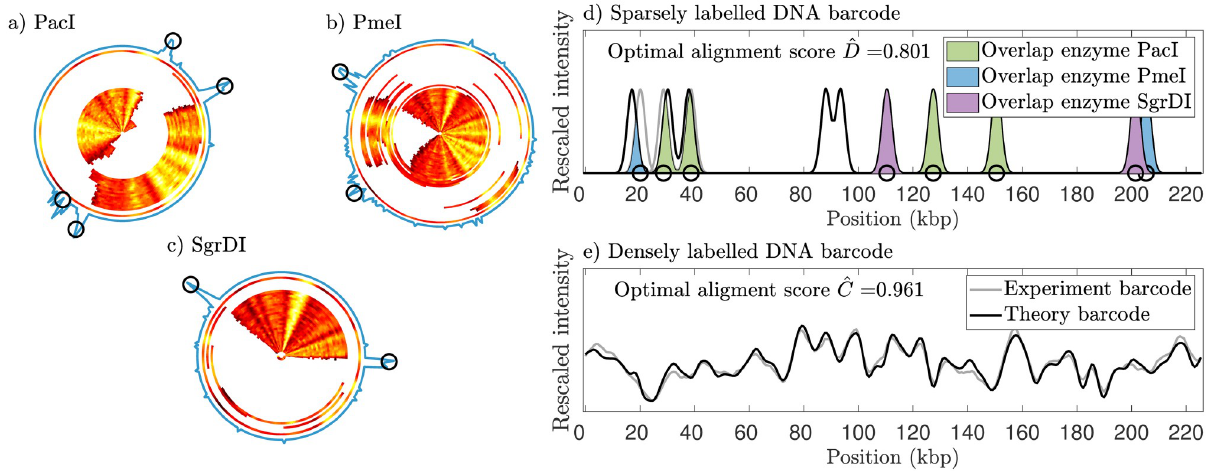
Fig 5. Experimental dually labeled barcodes for the 220 kbps plasmid. Three data sets containing fragments of a 220 kbps plasmid were obtained using competitive binding barcoding and sparsely cut-labeled barcodes obtained through full digestion using the restriction enzymes (a) PacI, (b) PmeI, and (c) SgrDI. The experimental competitive binding barcodes were aligned into a consensus barcode. The locations of cuts for each barcode are shown as white regions and the determined locations of significant clusters of cuts (see Methods) are shown by the black circles. (d) Three theoretical cut- labeled barcodes have been aligned to the corresponding experimental cut-labeled barcodes in the orientation and circular shift where the alignment score, Eq (2), is maximized. Enzyme PacI produced four cuts while enzyme PmeI and enzyme SgrDI produced two cuts each. The regions of overlap between experimental and theoretical barcodes corresponding to the same enzyme have been highlighted. (e) Densely labeled experimental consensus barcode aligned to the corresponding theoretical barcode. The alignment is at the orientation and circular shift where its alignment score, Eq (3), is maximized. The intensity values have been re-scaled such that the intensity values of each barcode have the same mean and standard deviation as the other.